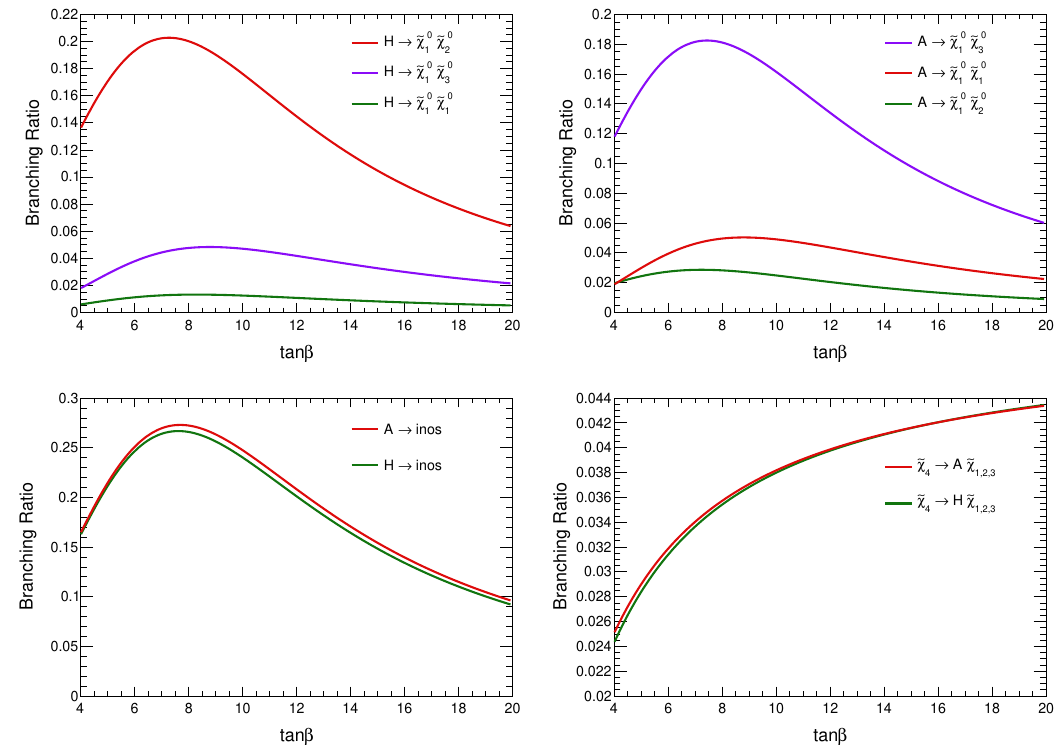
Figure 2. Dominant branching ratios for heavy CP-even and CP-odd Higgs decays to individual electroweakino modes (top panel), the total branching ratio for two heavy Higgs (bottom left), branching ratio of heaviest neutralino decays to heavy Higgs (bottom right) for the case-1b. The wino, bino, higgsino mass parameters M 2 , M 1 , µ are fixed at 1500, 300 and 450 GeV and tan β is